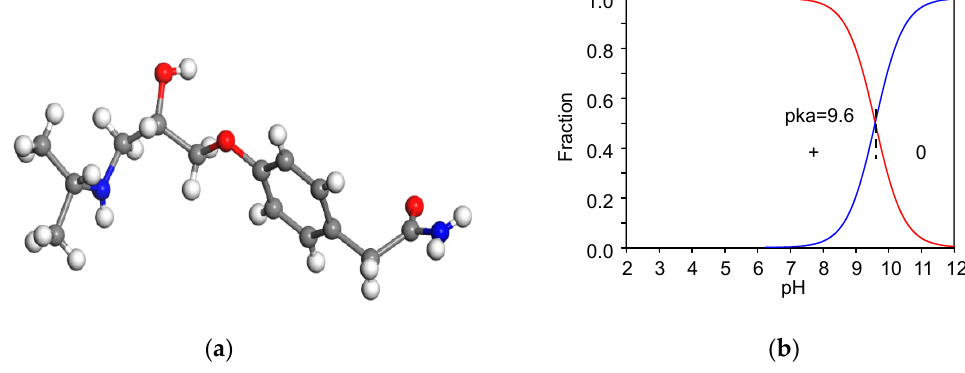
Figure 1. Molecular structure of AT ( a ) and their speciation under di ff erent pH values ( b ),